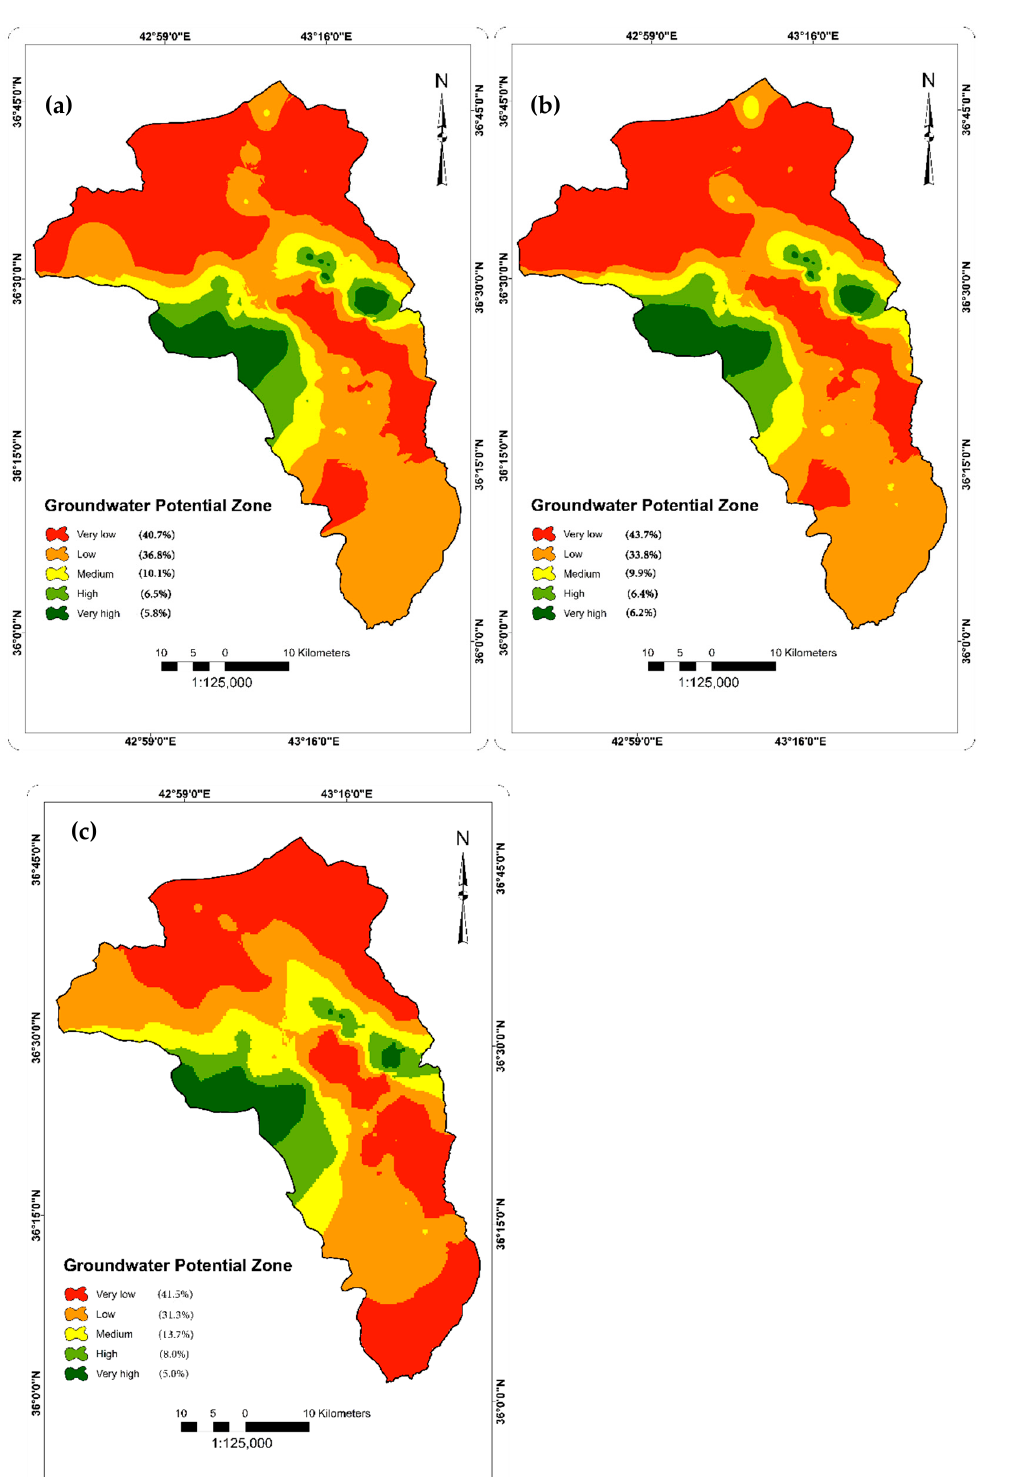
Figure 12. Groundwater potential maps by ensemble models: ( a ) all best performance models, ( b ) all similar pattern models, and ( c ) all used models.